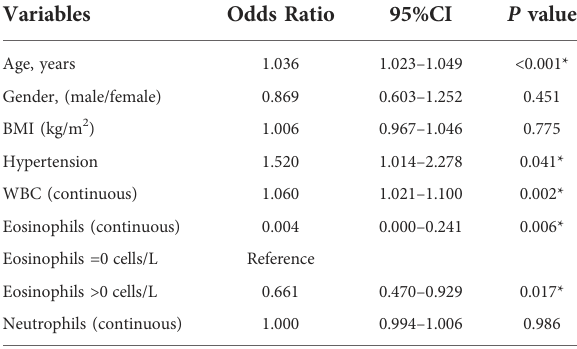
TABLE 4 Predictors of mortality after AAAD surgery in univariate logistic regression.